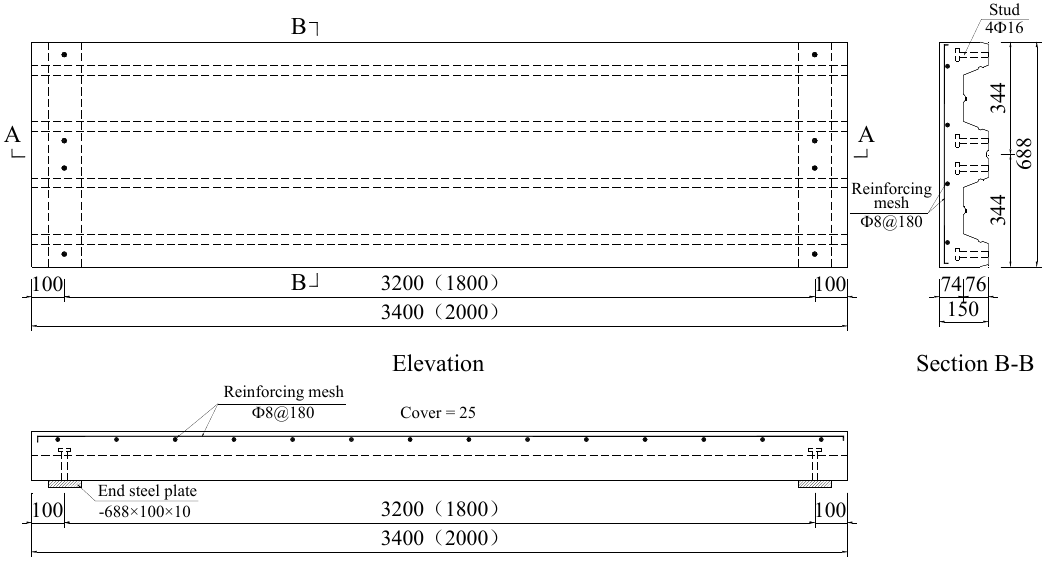
Figure 4. Details of test specimens (all dimensions are in mm). The symbol “ Φ ” represents the yield strength of the reinforcing bar is of grade 300 N/mm 2 .